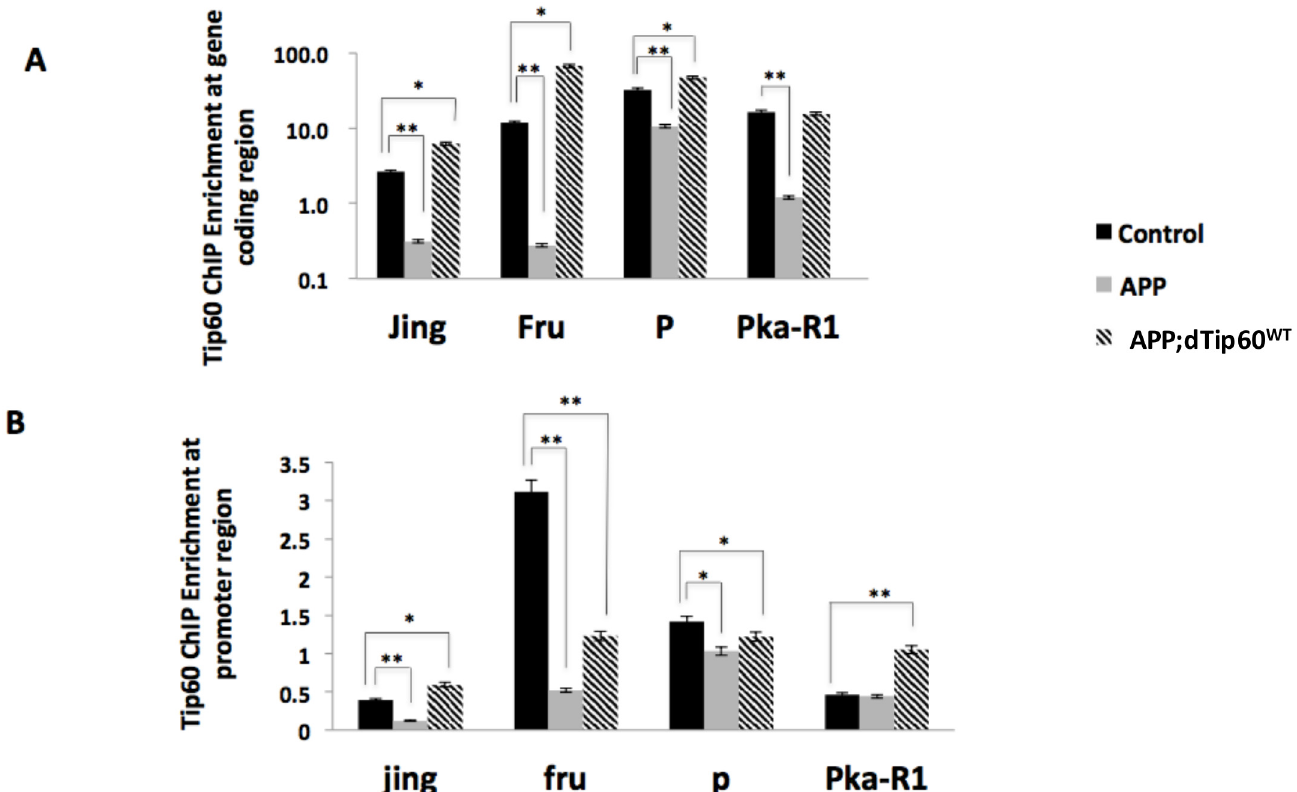
Fig 6. Tip60 restores reduced histone acetylation levels under EE conditions by directly binding at both promoter and gene coding regions of cognition gene loci under APP induced neurodegenerative conditions. Tip60 displays similar enrichment pattern as histone acetylation on wild-type, APP flies and APP;Tip60 fly. (A)Tip60 ChIP at coding region. (B)Tip60 ChIP at selected promoter region. Newly enclosed adult fly progeny were exposed to a group of 30 flies (1:1 sex ratio) to generate EE conditions as previously described. Fold enrichment was compared among